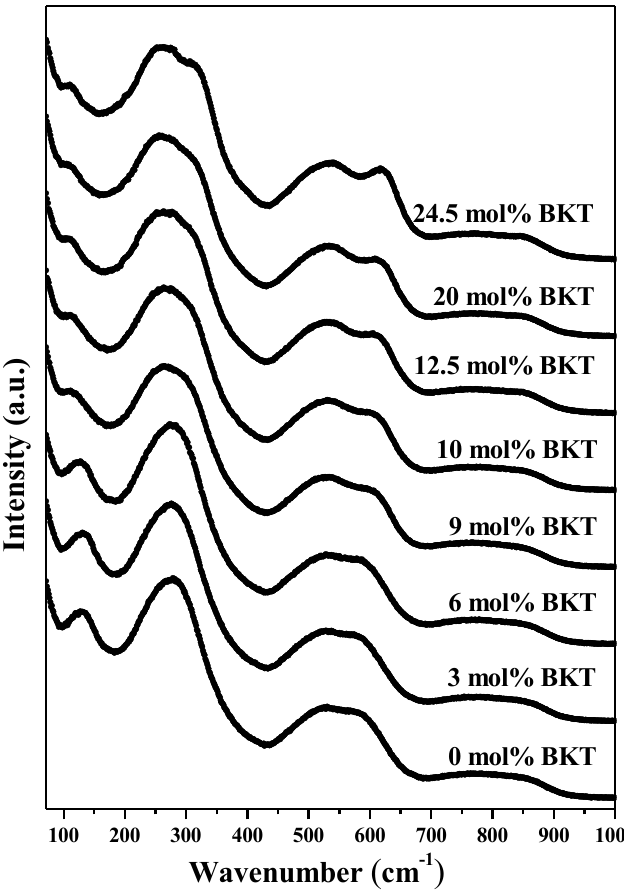
Figure 2. Raman spectra recorded in a wavenumber between 80 to 1000 cm − 1 of sintered ceramics in compositions (97.5 − x )BNT + x BKT + 2.5BT with x = 0/3/6/9/10/12.5/20/24.5 mol % BKT.